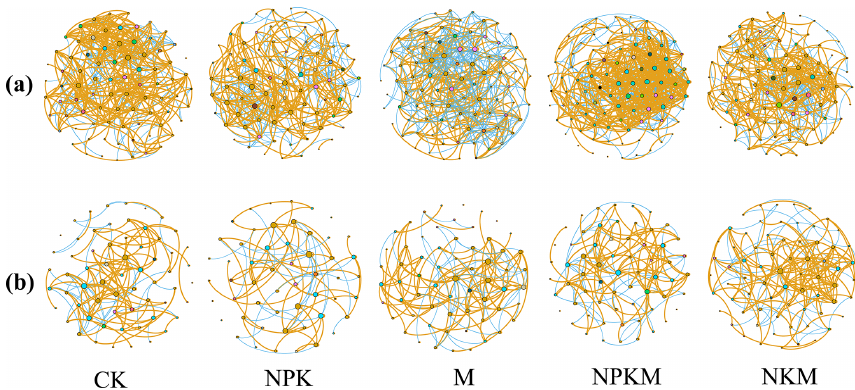
Figure 6. Network of co-occurring (a) bacterial and (b) fungal OTUs across five fertilizer treatments. Only Spearman’s correlation coef- ficient r > 0 . 6 or r < − 0 . 6 significant at P < 0 . 01 is shown. The nodes are colored according to phylum. Orange edges represent positive correlations and blue edges represent negative correlations. Node size presents the connecting numbers of each OUT.